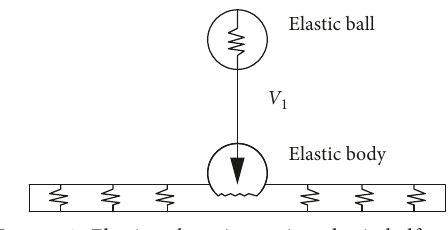
Figure 3: Elastic sphere impacting elastic half space.